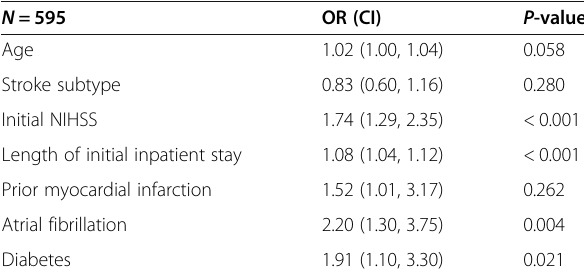
Table 2 Factors predicting membership of the moderately compared to mildly affected class